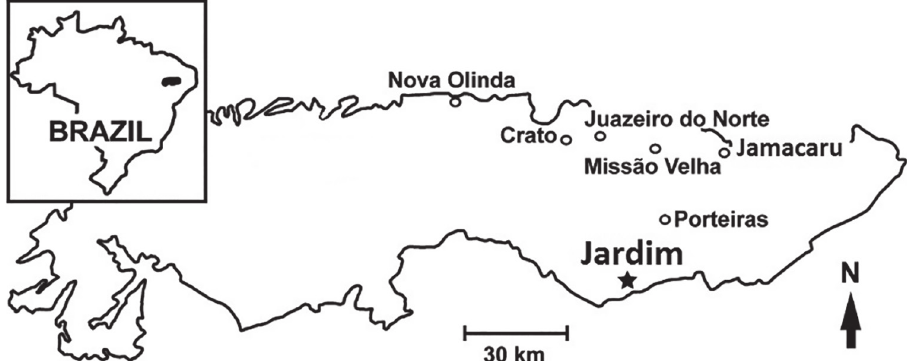
Figure 1 - Geographic position of the sampling site in the town of Jardim, Araripe Basin, south of the state of Ceará, northeast Brazil.